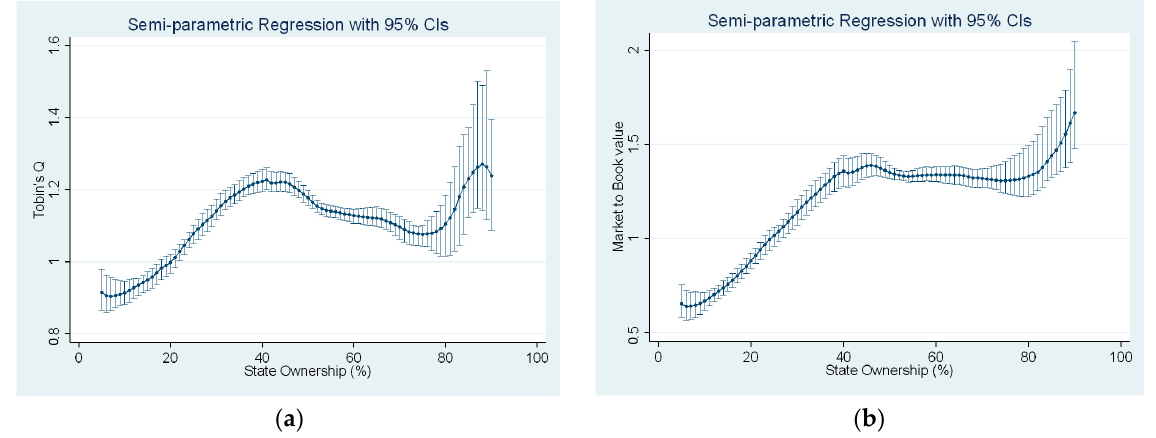
Figure 4. Semiparametric IV estimates of firm’s Tobin’s Q ( a ) and market to book value ratio ( b ) on state ownership (%). This figure presents the marginal effect of state ownership on partially privatized firm’s Tobin’s Q and market to book value ratio. The continuous lines correspond to the estimates, whereas the capped spikes correspond to the 95% confidence intervals.